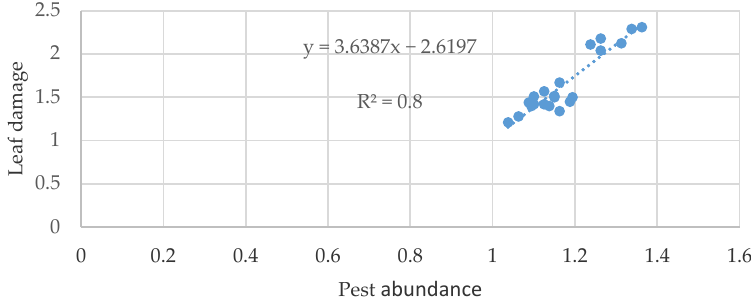
Figure 3. Correlation between leaf damage and aphid abundance.